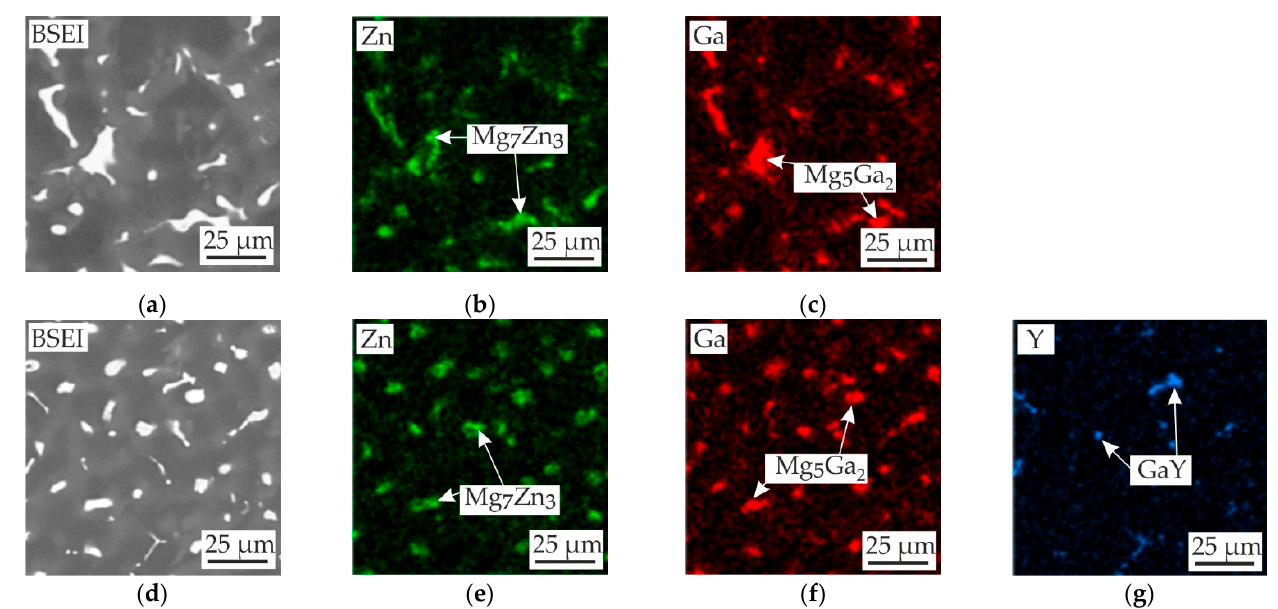
Figure 2. BSEIs ( a , d ) and EDS maps showing the distribution of ( b , e ) Zn, ( c , f ) Ga, and ( g ) Y in the as-cast ( a – c ) MgZn4Ga4 and ( d – g ) MgZn4Ga4Y0.5.